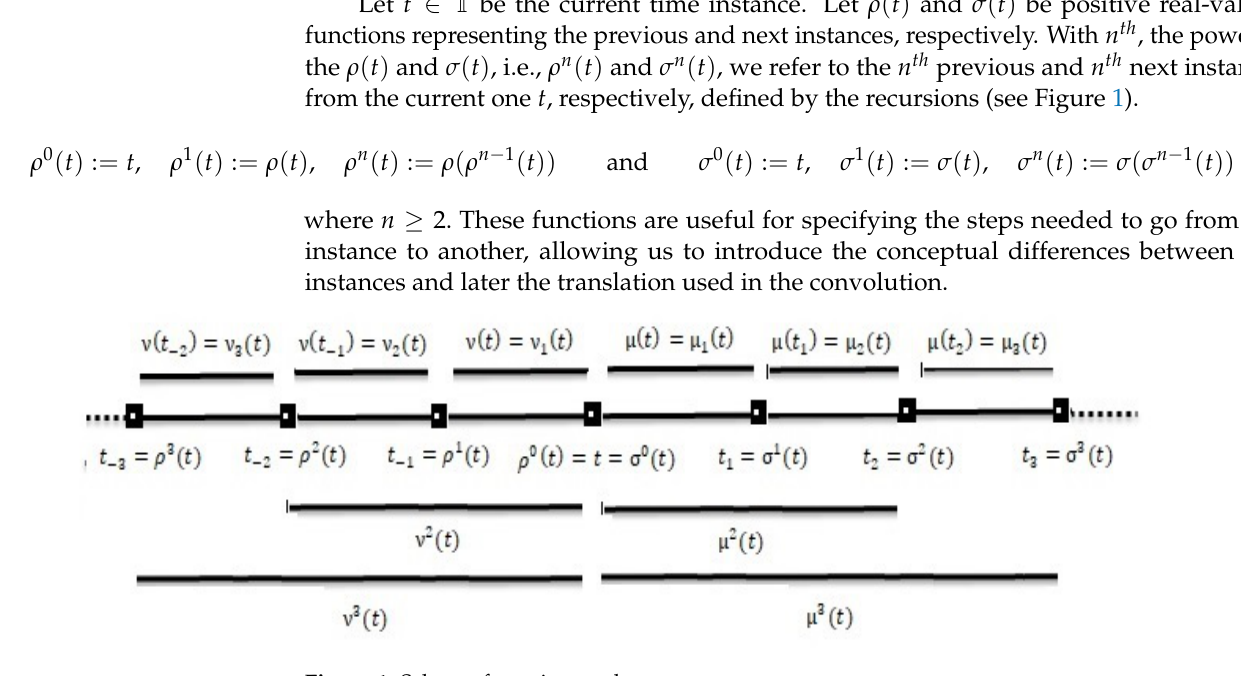
Figure 1. Scheme for a time